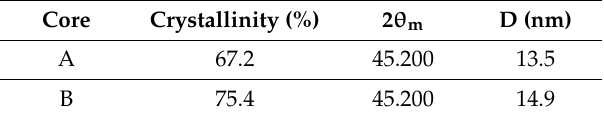
Figure 1. XRD scans obtained for the two nanocrystalline samples: A (red) and B (black) core. Table 1. Numerical data on the partial crystalline phase and grain size.